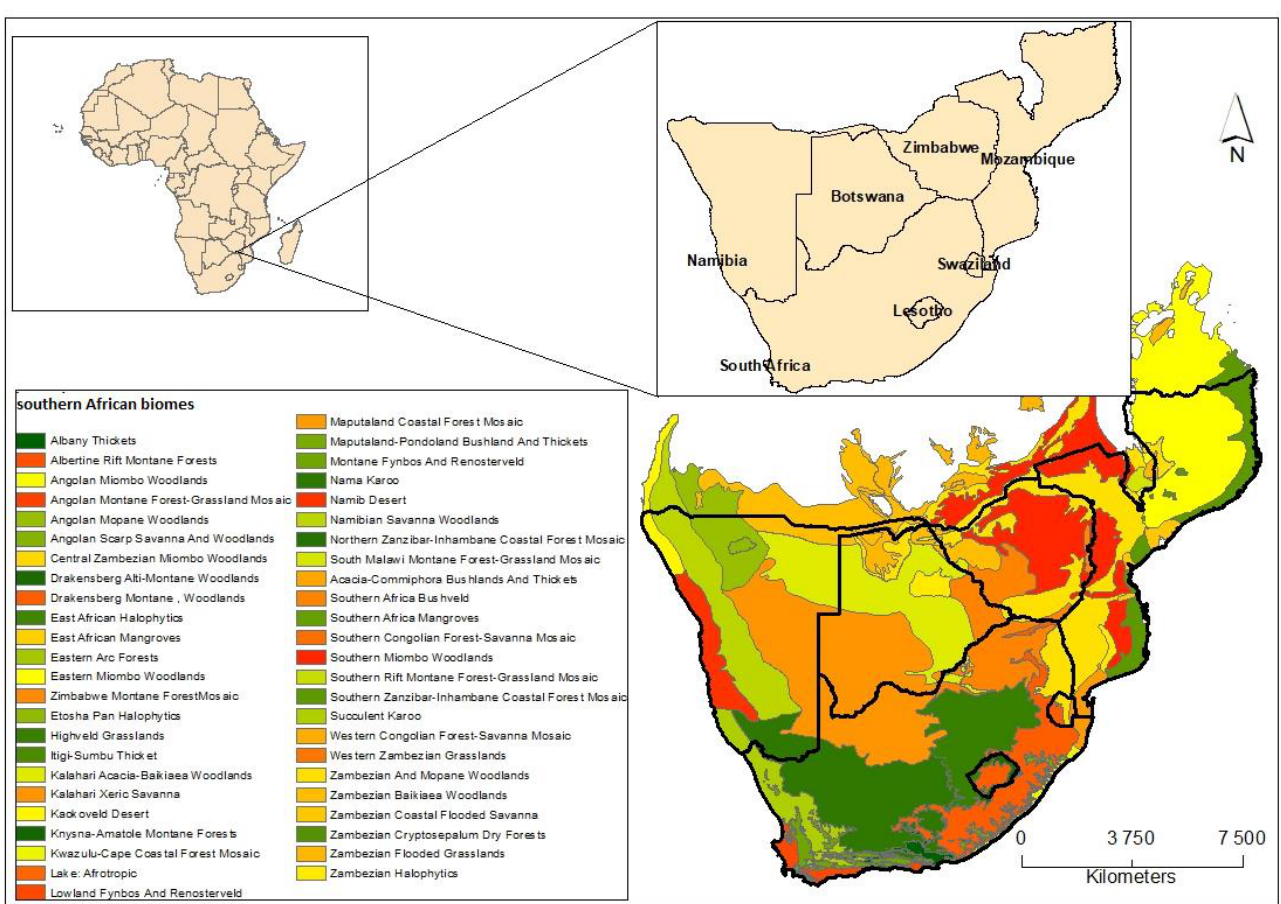
Figure 1. Location of South Africa in relation to its neighboring countries with a highlight of the diversity of regional biomes. diversity of regional